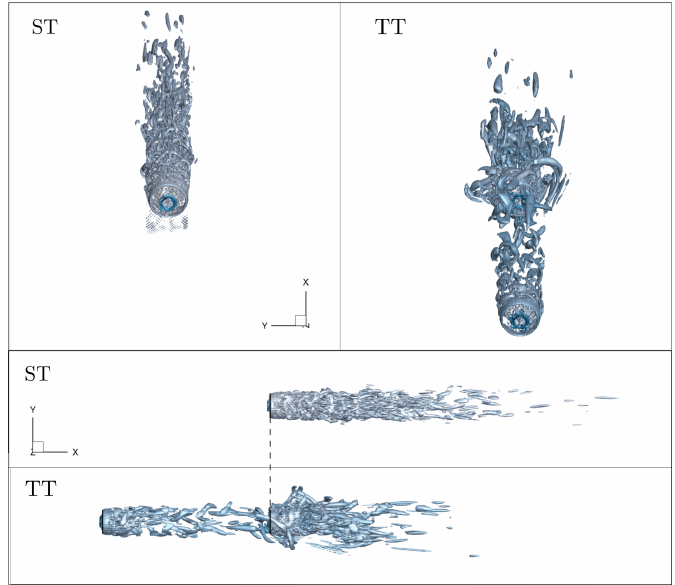
Figure 6. Instantaneous q -iso surfaces from two different perspectives. Both cases show the annular vortex produced by the averaged blade tips and the high pressure point at the nacelle area. Wake vortical structures are shorter for the TT case due to the larger turbulent intensity that faces the primary turbine in that case. The dashed line indicates the position of the downstream